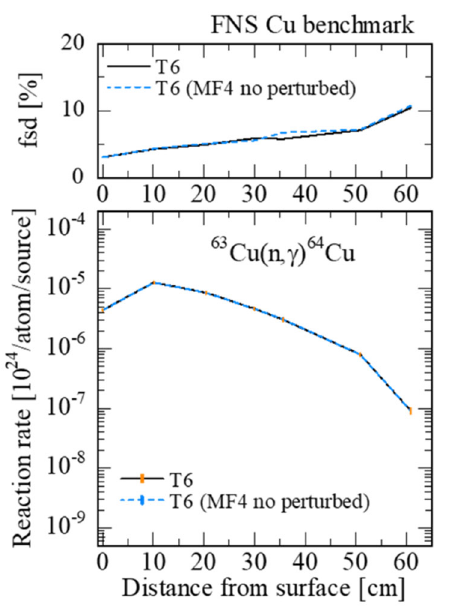
Fig. 9. Comparison of 63 Cu(n,  ) 64 Cu reaction rate distribution and the standard deviation between T6 and the result ignoring perturbation of angular distribution.